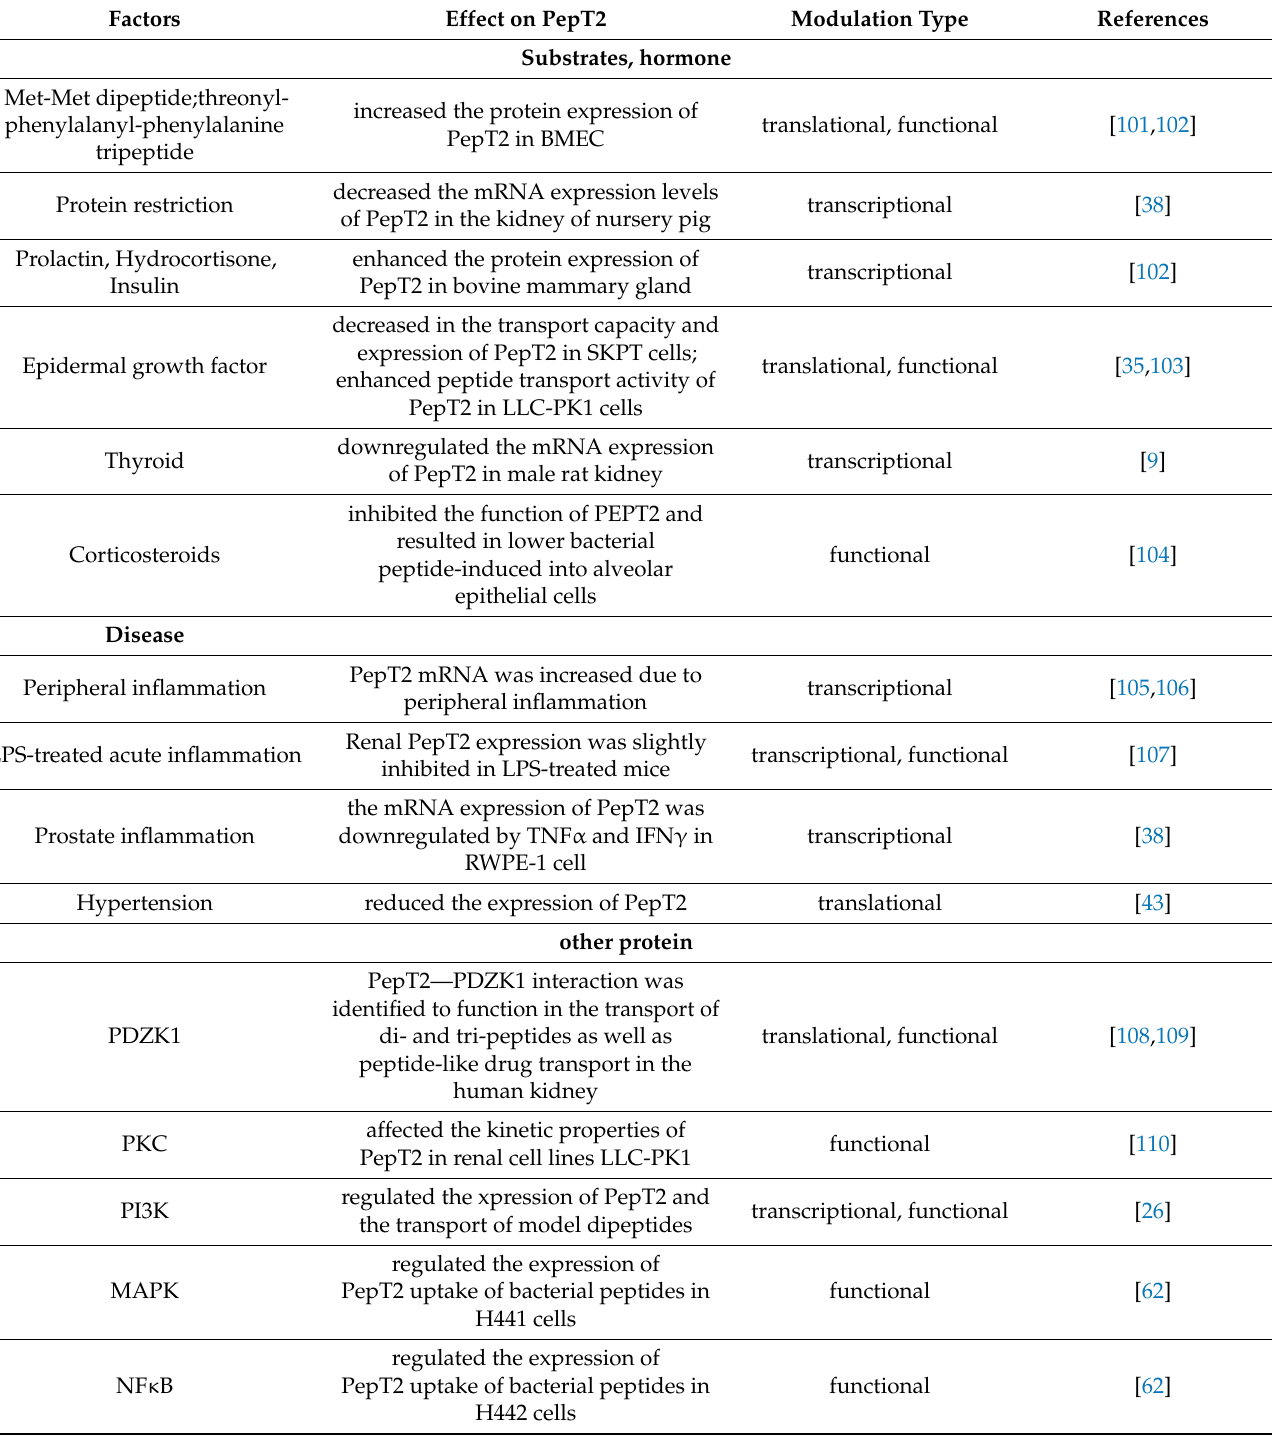
Table 2. Factors regulate the gene and or protein expression and function of